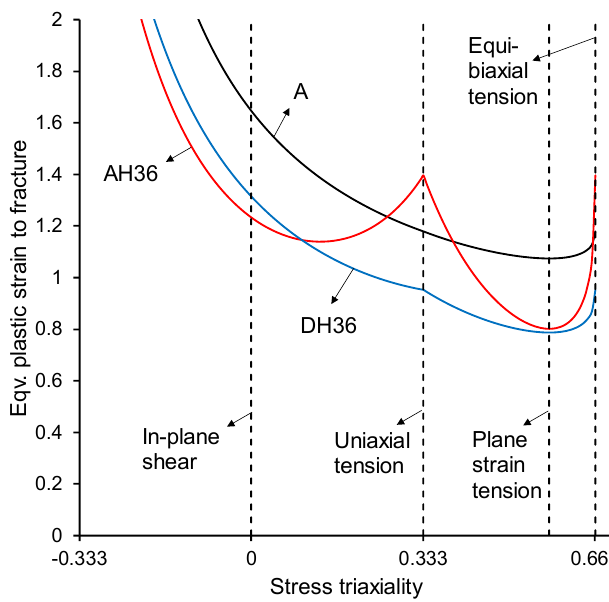
Figure 16. Calibrated 2D fracture loci of the steel grades considered.